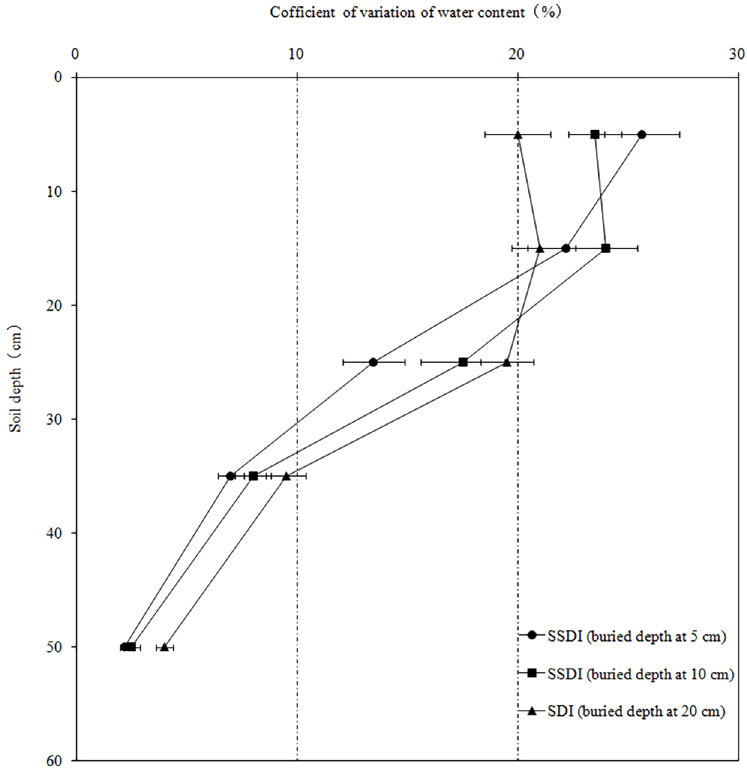
Fig 2. Coefficient of variation of water content in different soil layers (It was stable layer in 60–100cm).